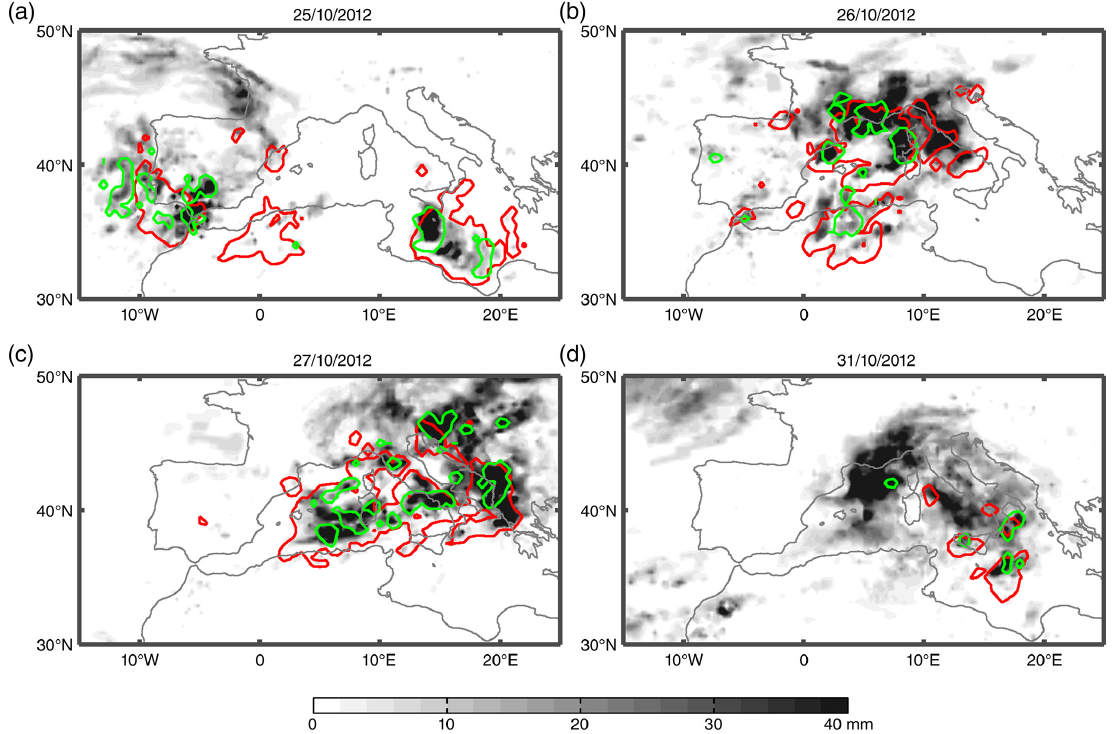
Figure 8. The 24h accumulated precipitation (grey shading) provided by the Tropical Rainfall Measuring Mission (TRMM), areas of light- ning activity (red contours, denoting areas with at least five impacts) from ZEUS (National Observatory of Athens) and areas of deep convection (green contours) as diagnosed from the microwave humidity sounder (MHS) radiometer. Reprinted from Flaounas et al. (2016) with